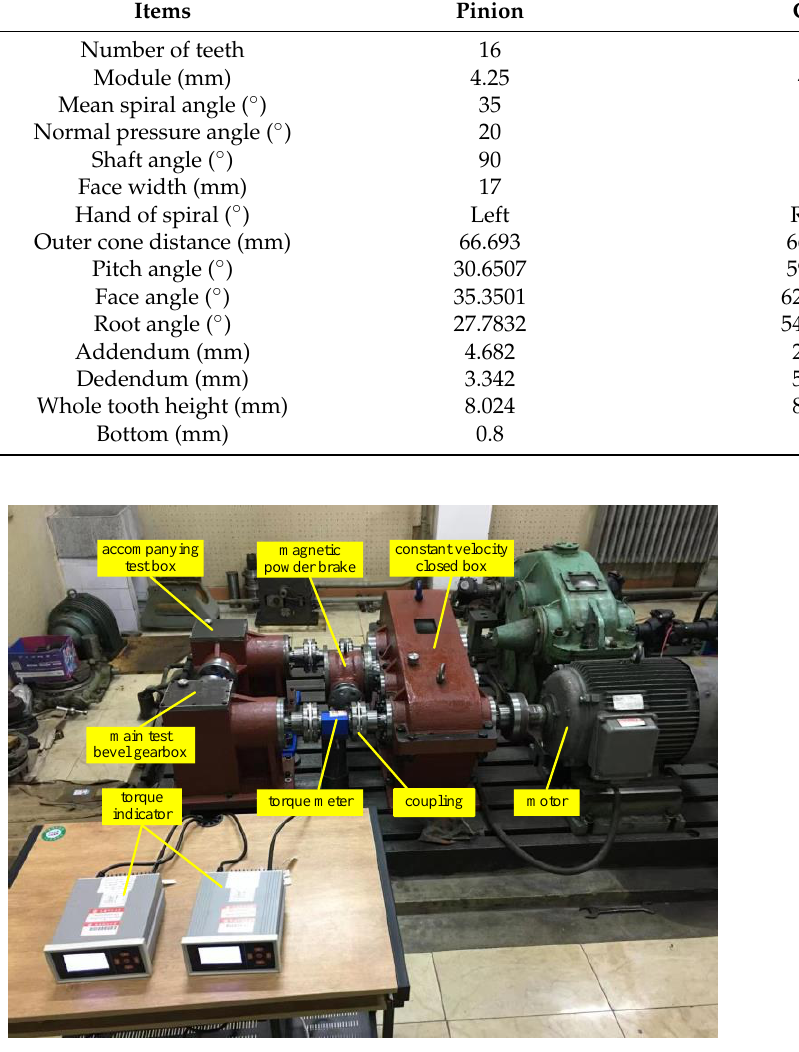
Figure 10. Test bench of spiral bevel gear fatigue life.